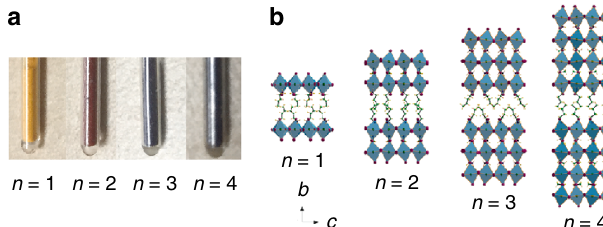
Fig. 1 Two-dimensional perovskites and the corresponding crystal structures. a Photograph of sample powders in capillary tubes, showing bandgap blueshift upon decreasing the layer number, n . b Crystal structures viewed along the (100) crystallographic projection. The elements in the crystals are represented by different colors: Pb in dark green , I in purple , N in dark blue , H in yellow , and C in light